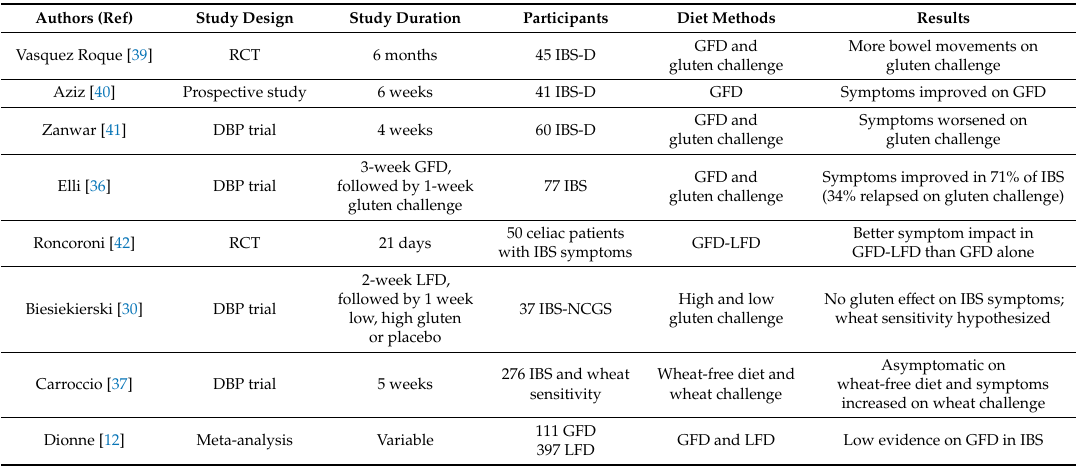
Table 2. Summary of the most significant studies on gluten and wheat-free diet in